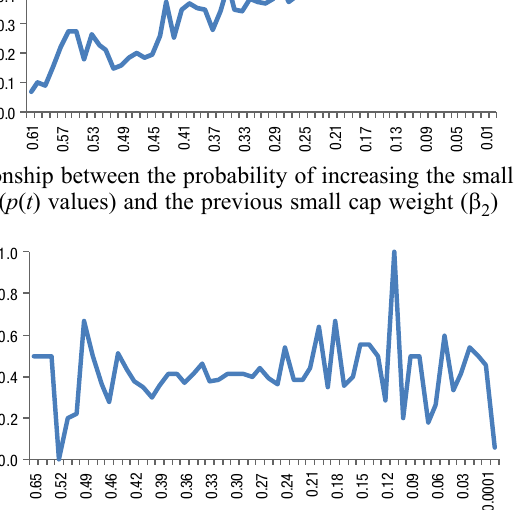
Fig. A.3. Relationship between the probability of increasing the fixed-income exposure ( p ( t ) values) and the previous fixed-income weight ( β